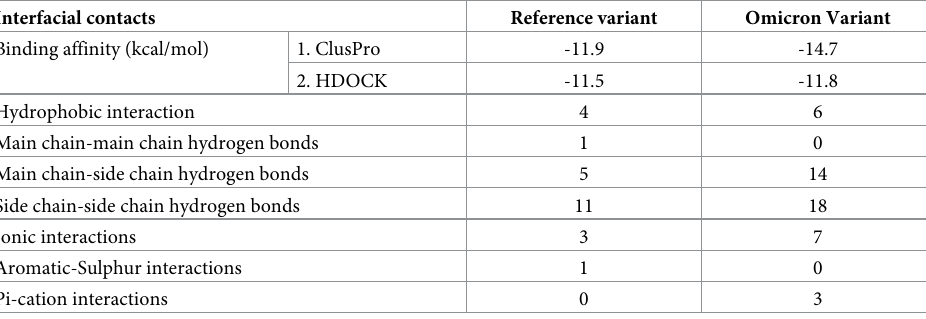
Table 5. Differences in interfacial contacts between reference and Omicron variant with